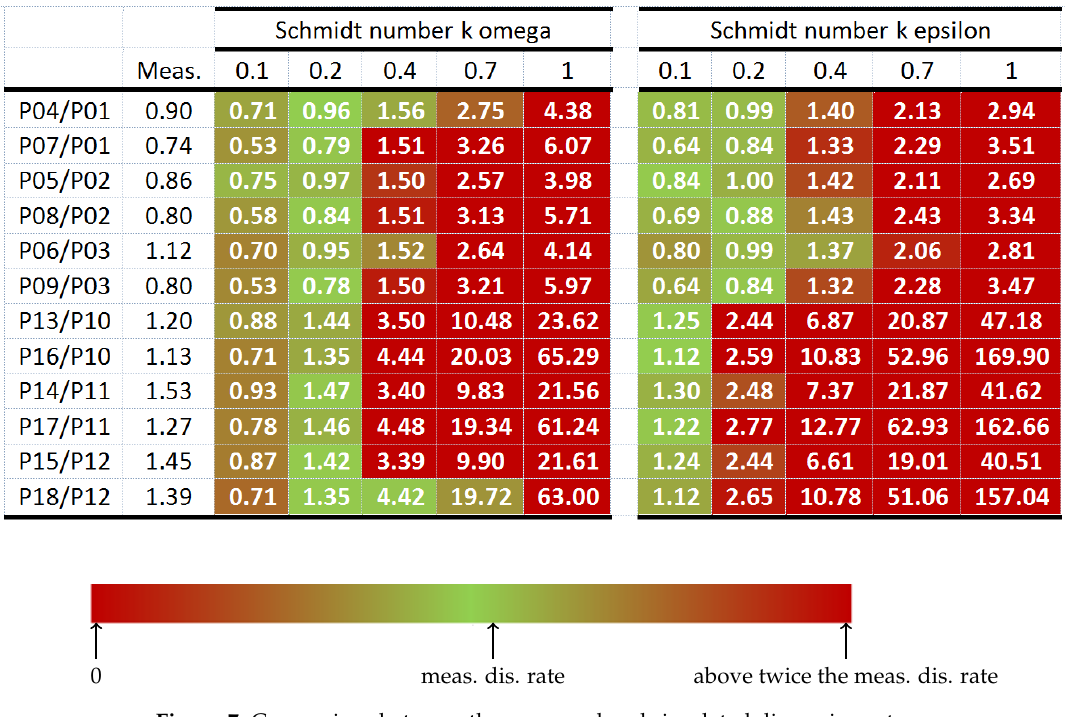
Figure 7. Comparison between the measured and simulated dispersion